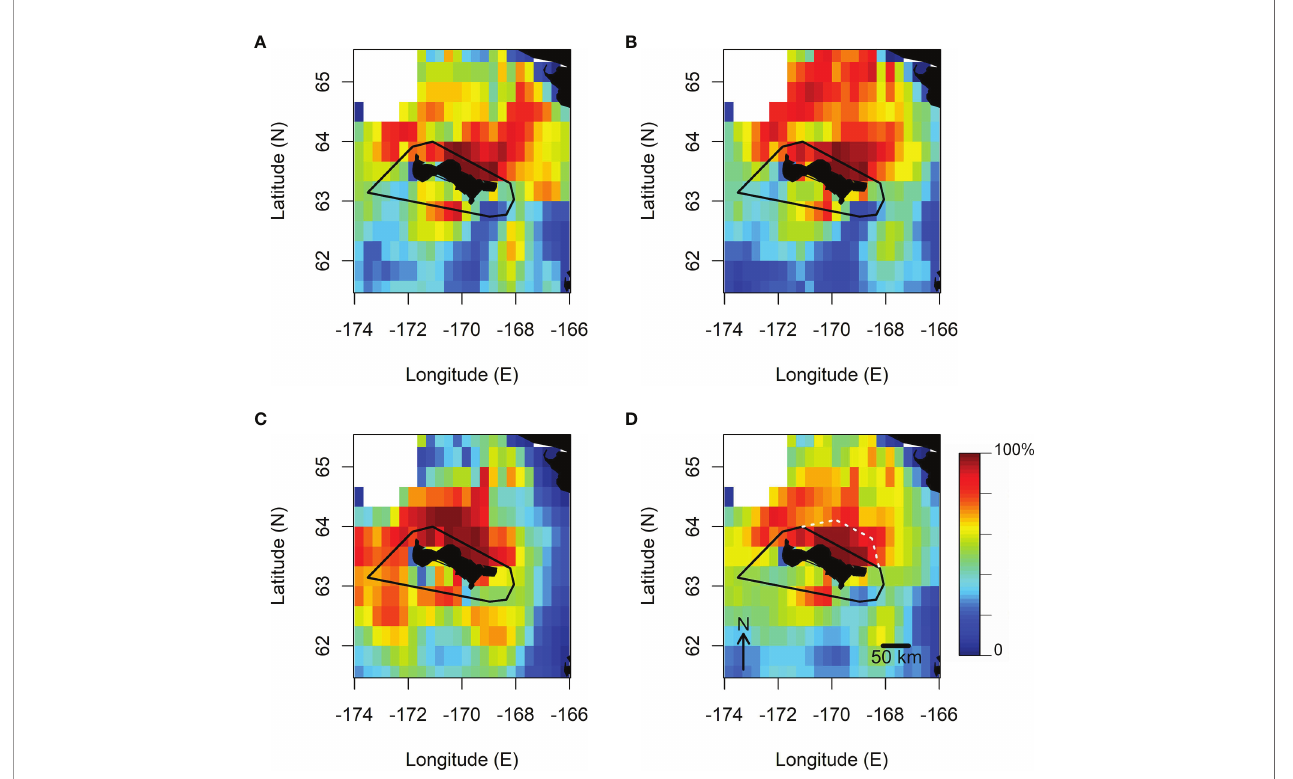
FIGURE 4 | Results of the Mahalanobis Distance Factorial niche analysis, showing the projected habitat suitability levels (expressed in %) of common murres (A) ; thick-billed murres (B) ; crested auklets (C) , and for the three species combined (D) . The boundaries of the ATBA around St. Lawrence Island is shown in black lines, and the white dashed lines indicate the suggested 35 km extension of the ATBA. These projection maps do not account for distance from the tracked colony as a covariate to evaluate regional habitat